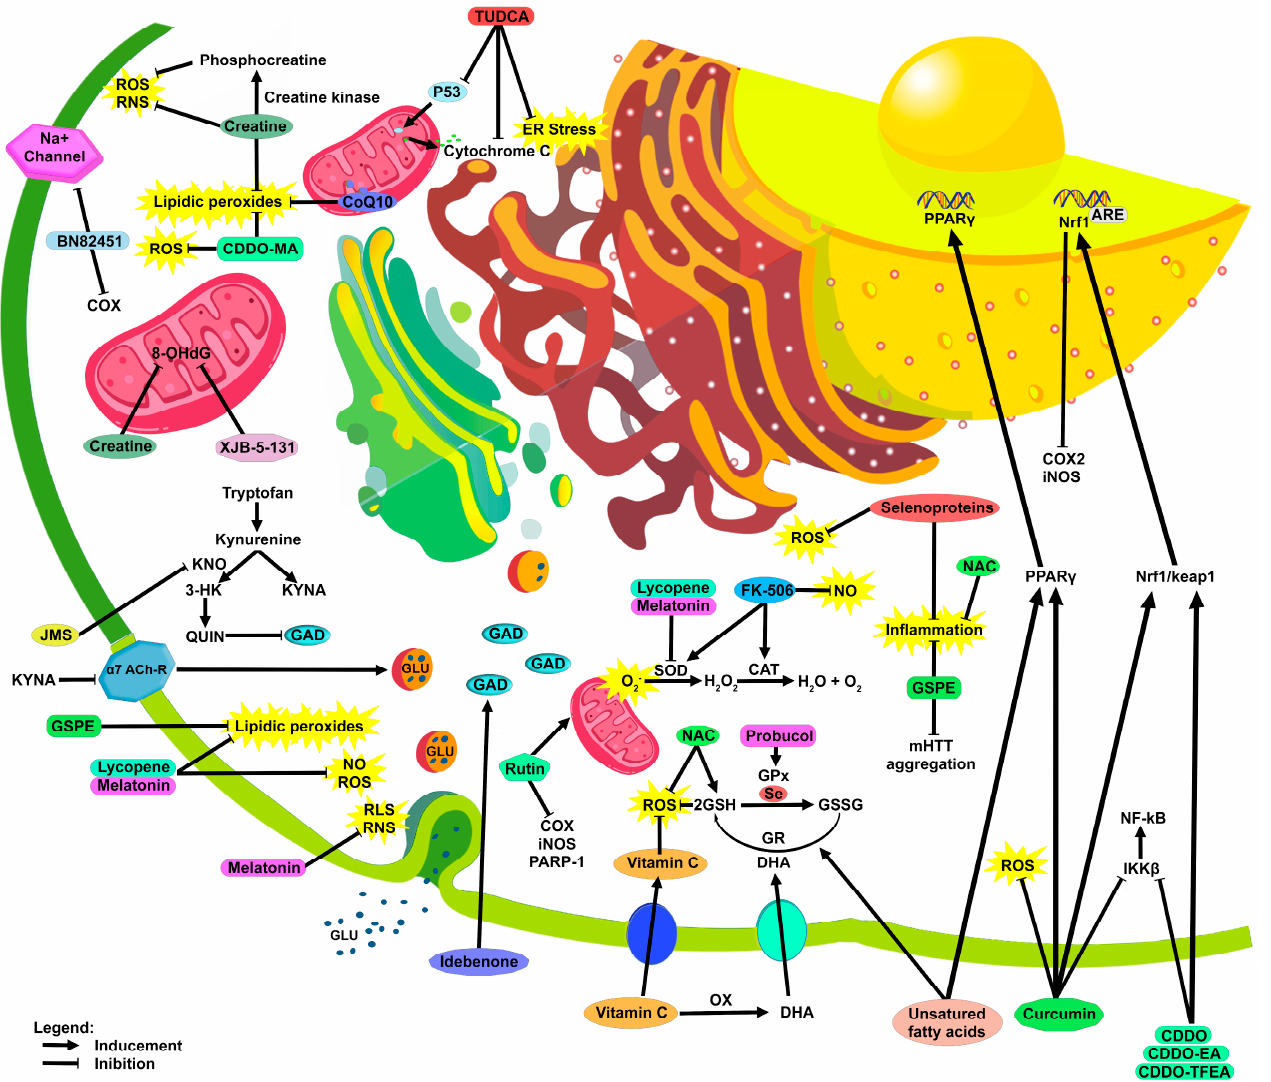
Figure 2. Mechanisms of action of the antioxidants discussed in the